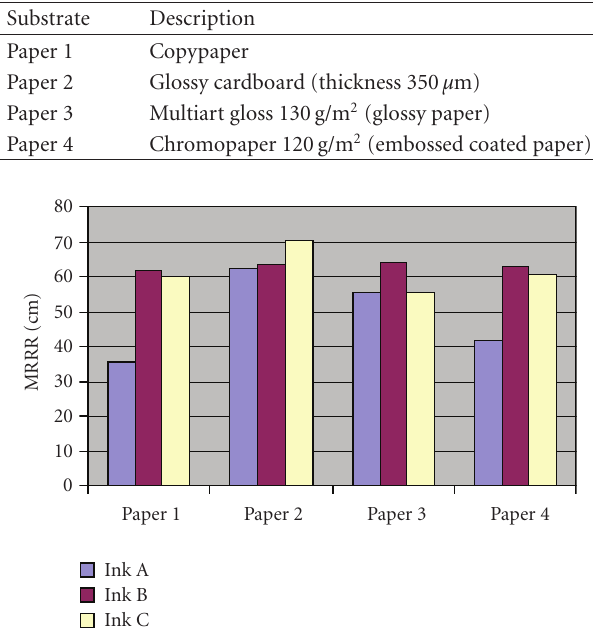
Figure 6: The average MRRR values, circularly polarized reader an-